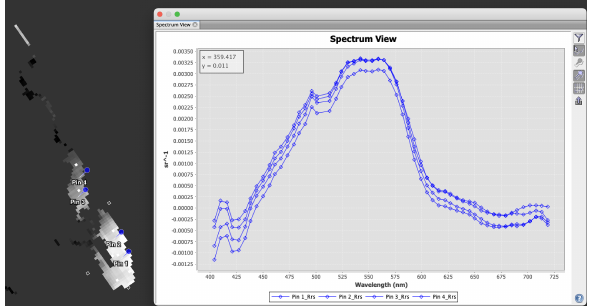
Figure 6. HICO Rrs reflectance, Tous